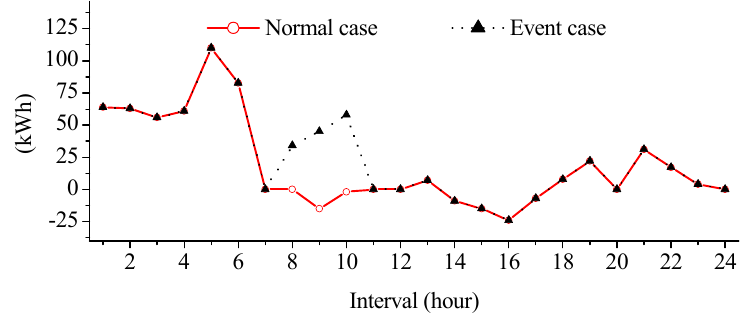
Figure 14. Comparison of the amount of power exchange with the utility grid.